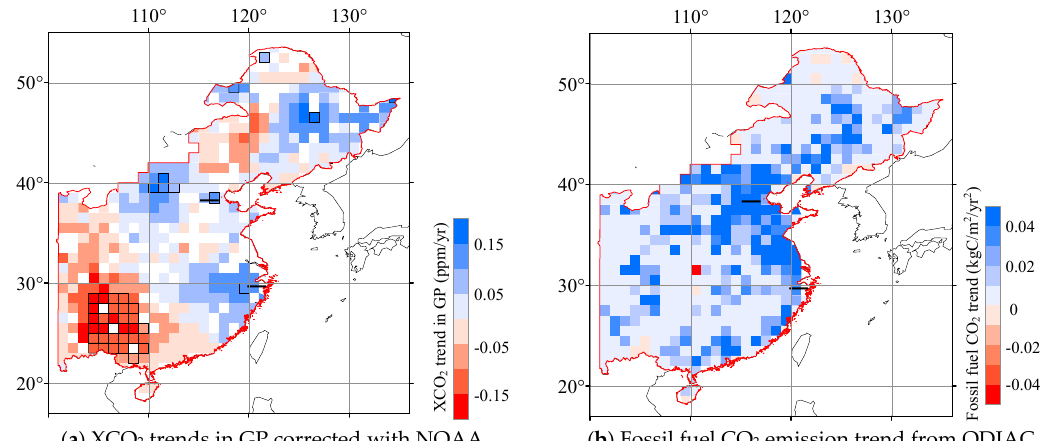
Figure 5. GM-XCO 2 trends from 2003 to 2015 in growing period corrected with NOAA annual increase ( a ). Negative values in red indicate an increase in XCO 2 drawdown during the growing period. Grid cells with black outlines indicate significant trends (Mann–Kendal test, p < 0.05). Increasing XCO 2 values in blue are likely due to a rise in annual fossil fuel emissions in the urban centers of Beijing (North) and Shanghai (South) labeled with black stars. ODIAC fossil fuel CO 2 annual emission trends from 2003 to 2016 support this interpretation ( b ). This GM-XCO 2 trend pattern shows the need to correct for trends in fossil fuel emissions within the study region of Eastern China.